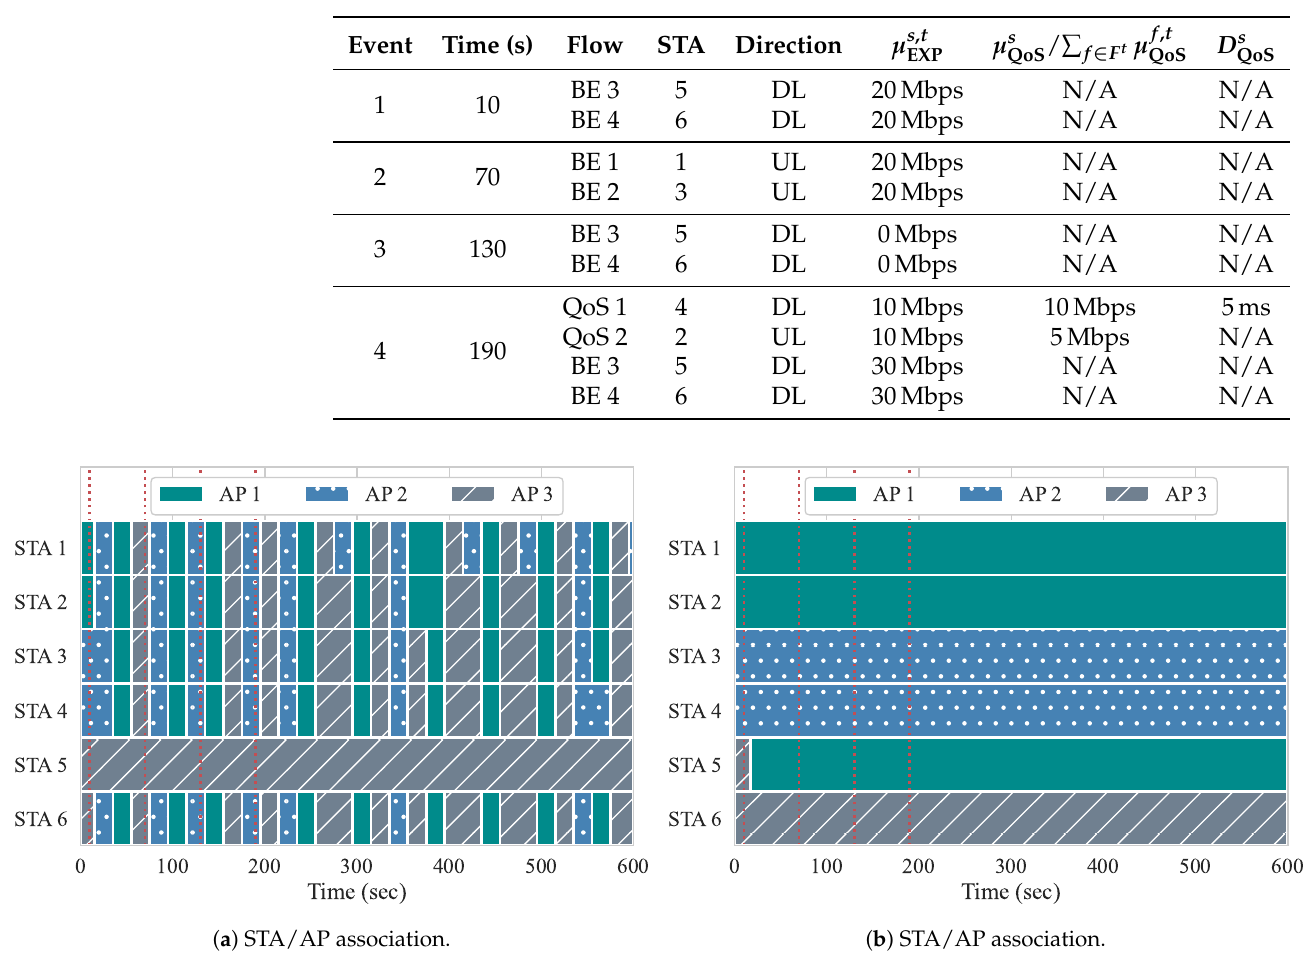
Table 7. Workload parameters used in experiment 3.